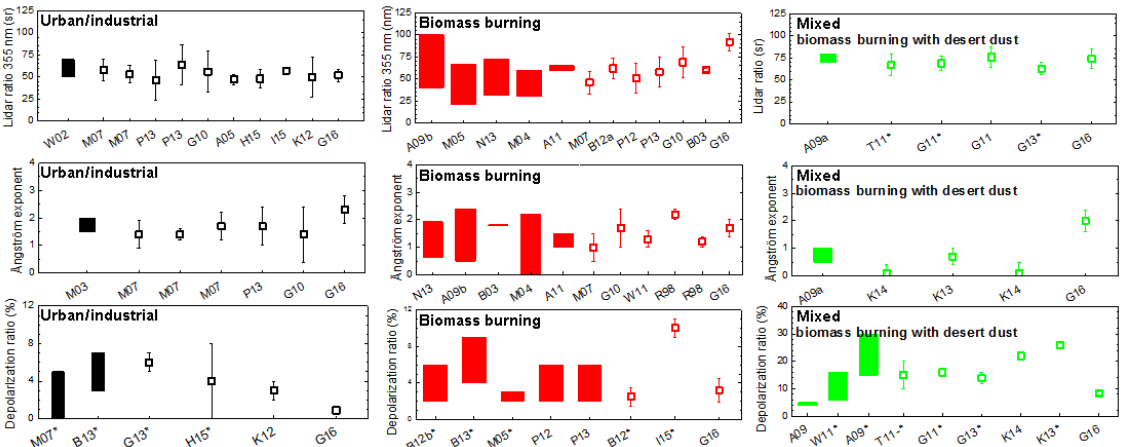
Figure 7. General literature values for lidar ratio at 355nm, Ångström exponent and depolarization ratio (355 or 532nm) for urban/industrial (black), biomass burning (red) and mixed biomass burning with desert dust aerosols (green). The x axes are the studies presented in Table 4. Floating columns refer to range values, while the symbols refer to mean values with 1 standard deviation. The depolarization values are at 355nm except for the cases noted with an asterisk ( ∗ ), which refer to visible wavelength (532 or 710nm).